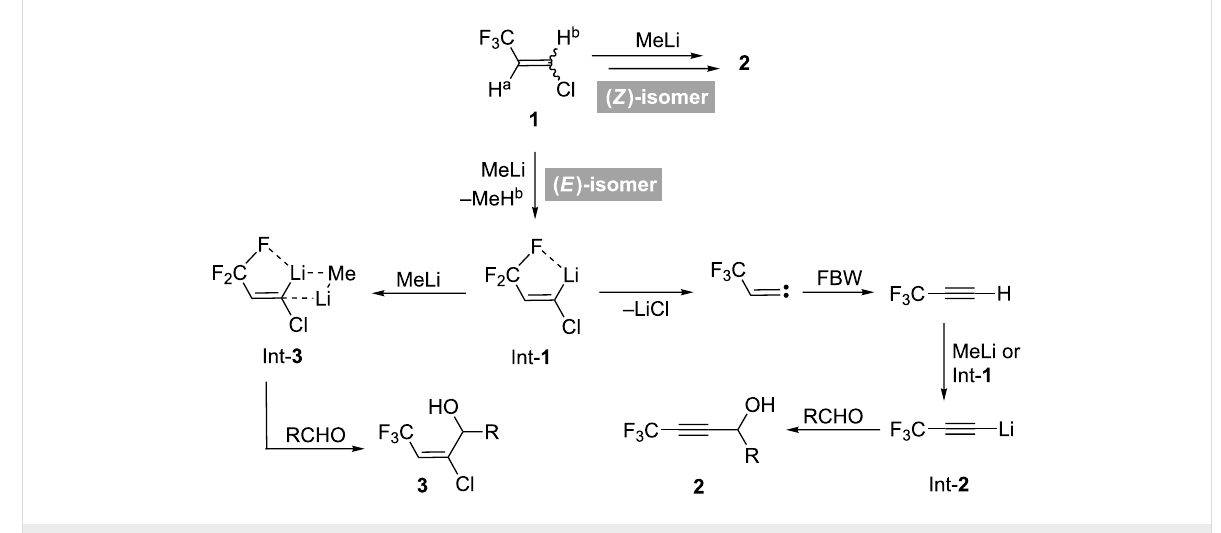
Scheme 1: Proposed reaction mechanism between 1 and